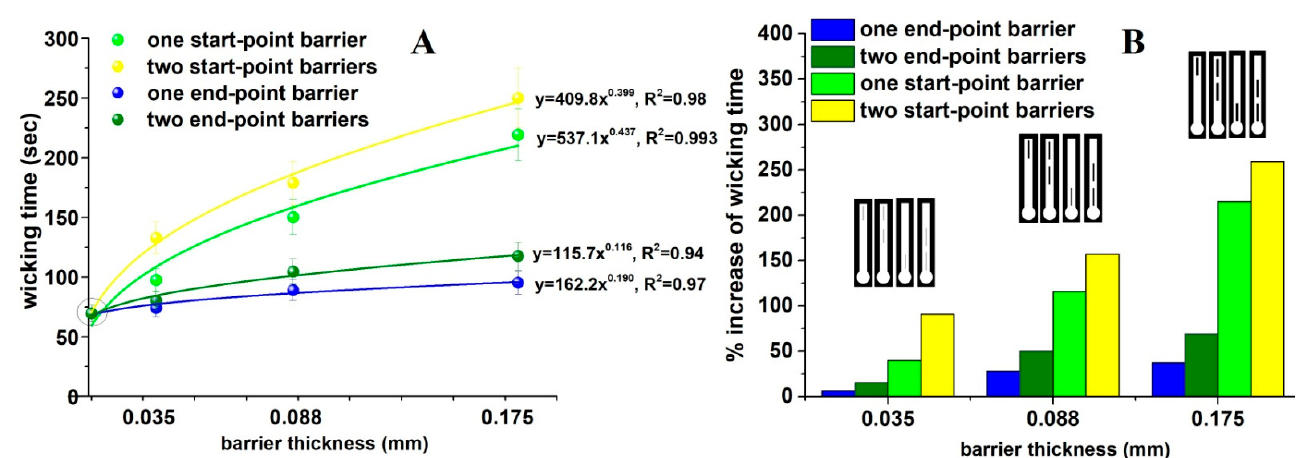
Figure 3. ( A ) Graph of wicking time as a function of linear line barrier width at the end and start of fluid flow. ( B ) Percentage increase in wicking time induced by each barrier compared to a regular (open) channel.